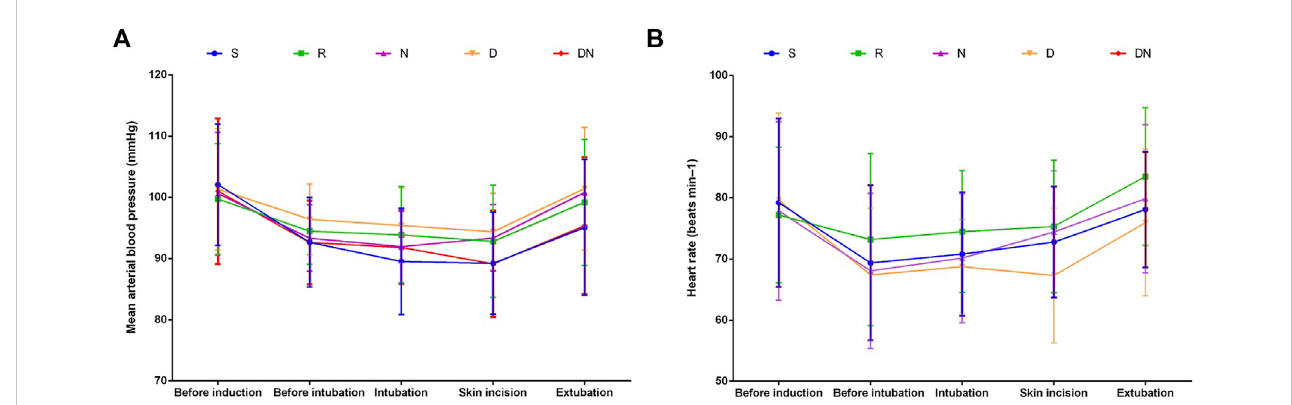
FIGURE 2 Intraoperative mean arterial blood pressure (A) and heart rate (B) . Group S: Intraoperative sufentanil 0.20 μ g kg − 1 and pre-anesthesia saline; Group R: Intraoperative remifentanil 0.20 μ g kg − 1 min − 1 and pre-anesthesia saline; Group N: Intraoperative remifentanil 0.20 μ g kg − 1 min − 1 and pre-anesthesia nalmefene 0.20 μ g kg − 1 ; Group D: Intraoperative remifentanil 0.20 μ g kg − 1 min − 1 and pre-anesthesia dexmedetomidine 0.50 μ g kg − 1 ; Group DN: Intraoperative remifentanil 0.20 μ g kg − 1 min − 1 and pre-anesthesia nalmefene 0.10 μ g kg − 1 combined with dexmedetomidine 0.25 μ g kg − 1 . All patients underwent laparoscopic gynecological surgery under des fl urane anesthesia. Values are presented as mean (SD).